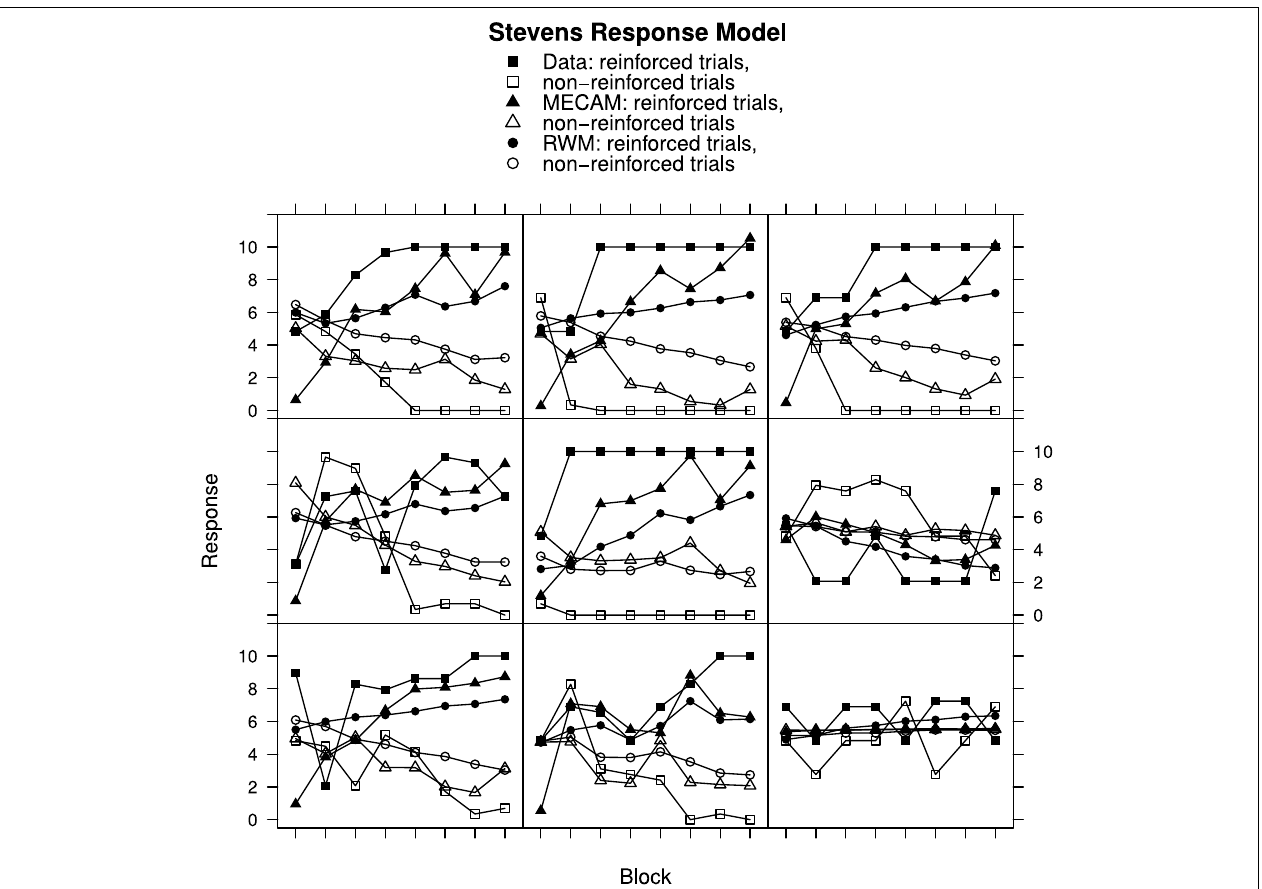
FIGURE 7 | Ratings, MECAM, and RWM predictions for reinforced and non-reinforced trials using the Stevens Response Model in Experiment 2. Top row , greatest MECAM improvement samples. Middle row , intermediate MECAM improvements. Bottom row , least MECAM improvement samples. See Results section on page 10 for further